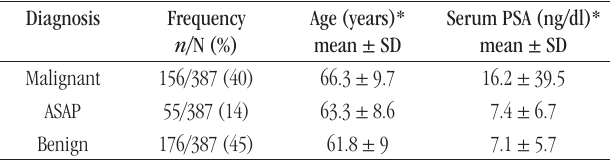
taBLE 1 − Frequency, age and serum PSA levels stratified according to the diagnosis after the examination of hematoxylin and eosin stained slides Diagnosis